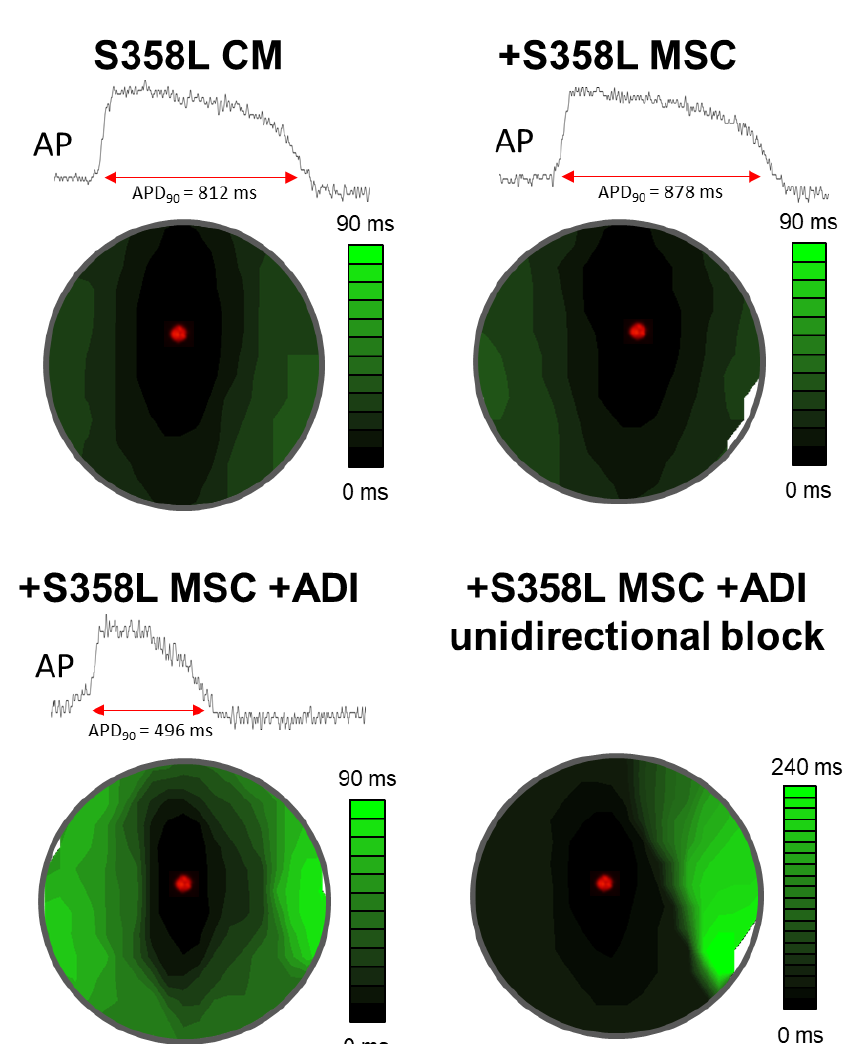
Figure 5. Representative action potential traces and activation maps for S358L cardiac myocytes (CM) alone ( top left ), or co-cultured with 3358L MSCs (+S358L MSC, top right ), or co-cultured with S358L MSCs plus pro-adipogenic factors (+S358L MSC +ADI, bottom). Only with pro-adipogenic factors was shorter APD 90 and slower CV (crowding of isochrone lines) observed ( bottom left ). Additionally, in some examples only with pro-adipogenic factors, unidirectional block was observed ( bottom right ).